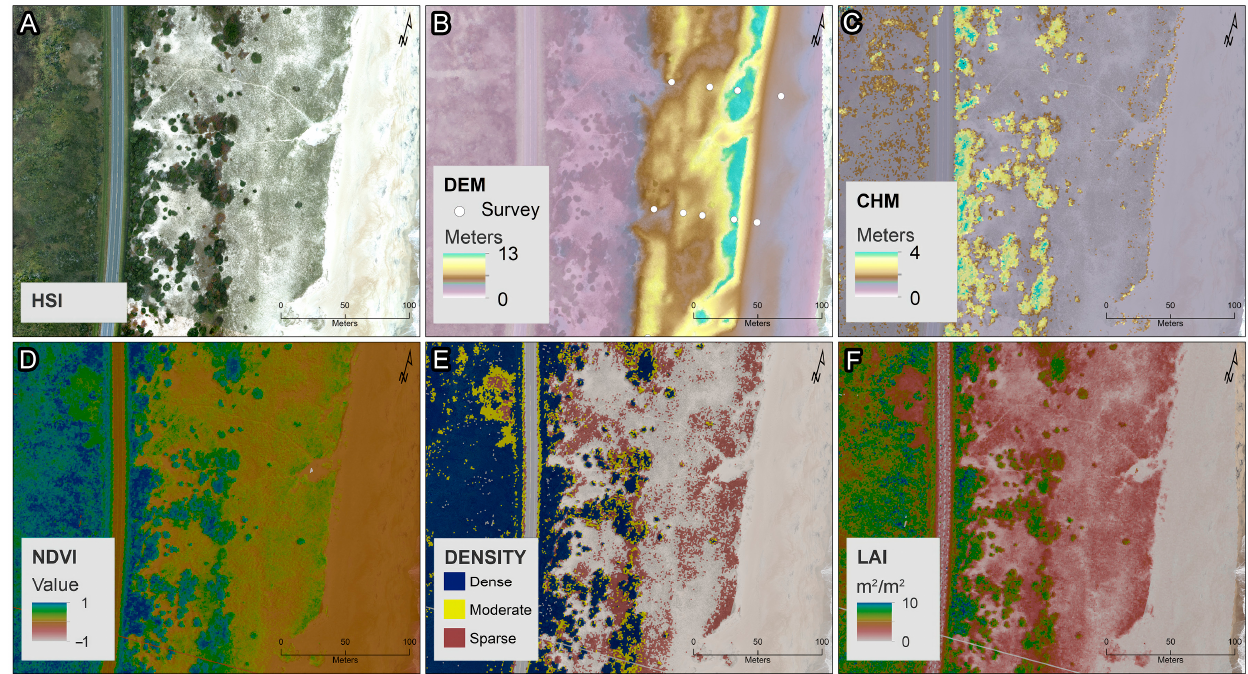
Figure 2. Example of the hyperspectral imagery ( A ), digital elevation model ( B ), canopy height model ( C ), normalized difference vegetation index ( D ), vegetation density ( E ), and leaf area index ( F ) within the Pea Island South assessment area.